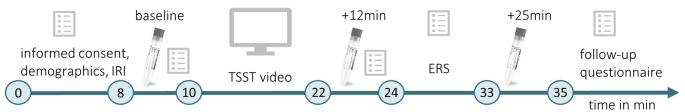
Timeline of Experiment 1. During the initial habituation phase (min 0–8), participants gave informed consent, completed a demographic questionnaire and the Interpersonal Reactivity Index (IRI; Paulus, 2009). The first baseline measurement of physiological and psychological stress indices was conducted (baseline, min 8–10) before participants watched a video of the Trier Social Stress Test (TSST; Kirschbaum et al., 1993, min 10–22). Subsequently, they provided another measurement of physiological and psychological stress indicators (min 22–24), which took place 12 min after the beginning of the video. After completing the Emotional Response Scale (ERS; Batson et al., 1997; min 24–33), the last physiological measurement was performed 25 min after the beginning of the TSST video (+25 min), and a follow-up questionnaire was completed.